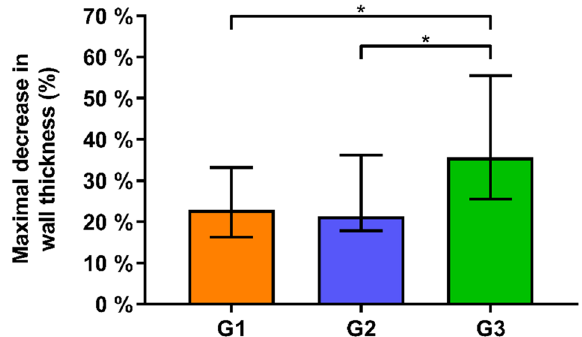
Figure 3. Maximal relative decrease in wall thickness (Max%DecWT) in the three study groups G1, G2 and G3 in terms of median and quartile-one|quartile-three (Q1|Q3) values, with stars indicating significant differences.